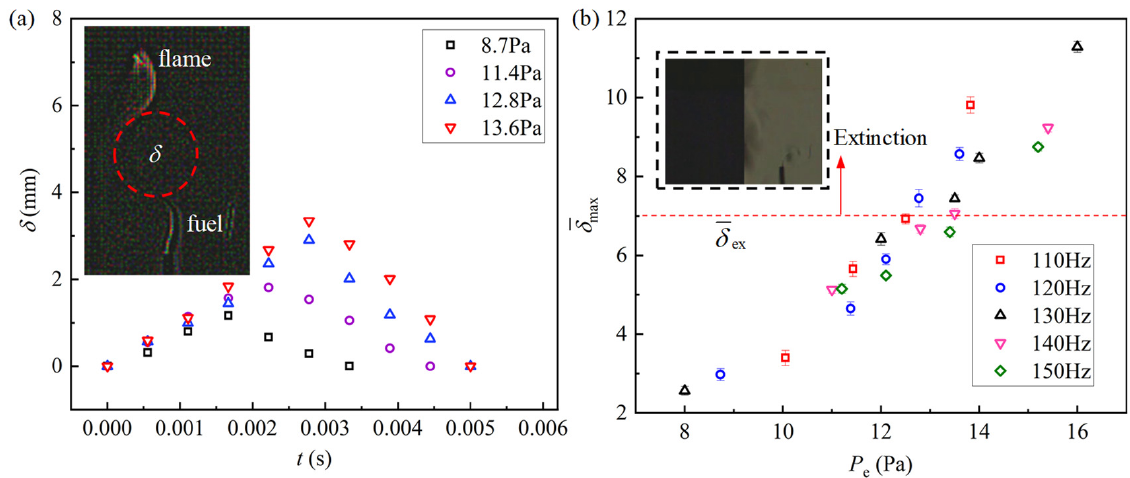
Figure 11. ( a ) Changes in the gap between the flame and the new unburned fuel; ( b ) the critical δ ex was a constant with different sound frequencies.